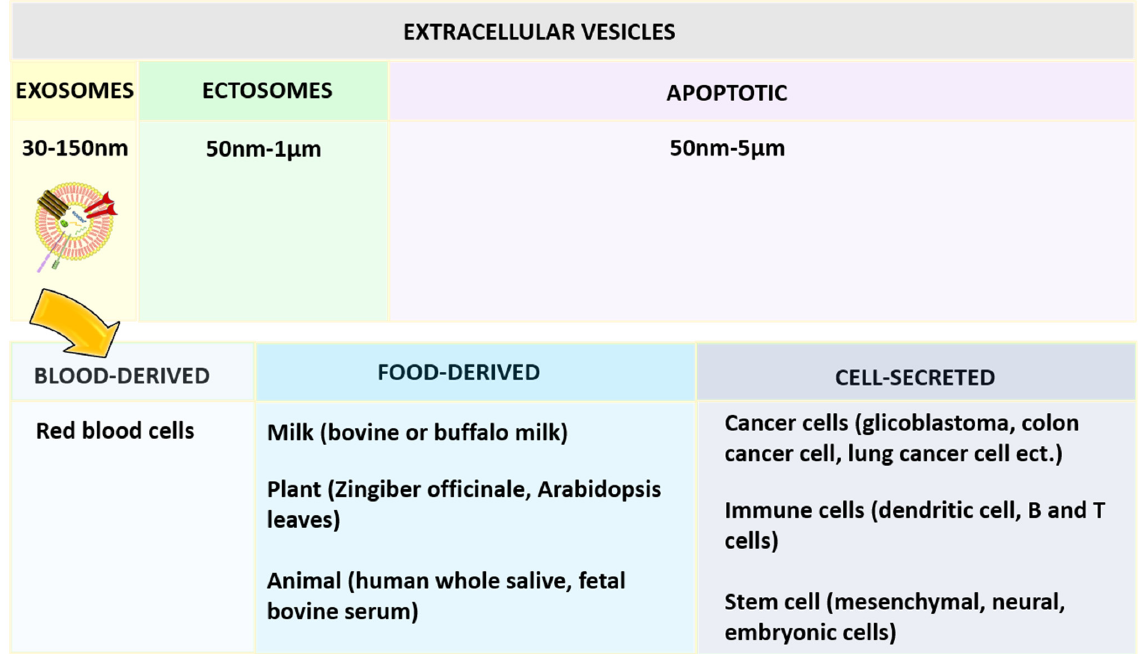
Figure 4. Classification of extracellular vesical based on the diameter and exosomes based on the source of origin.